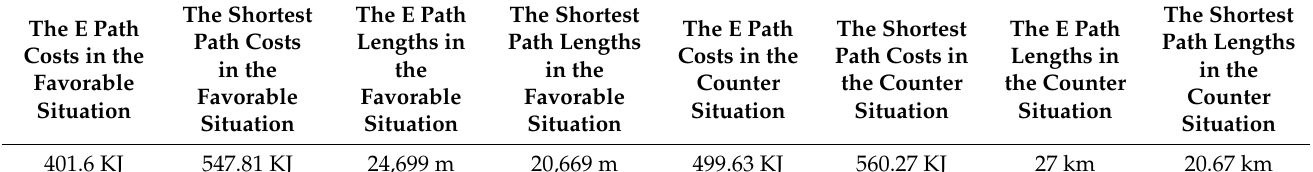
Table 8. The data of the minimal energy-consuming path and the shortest path in favorable and counter situations.